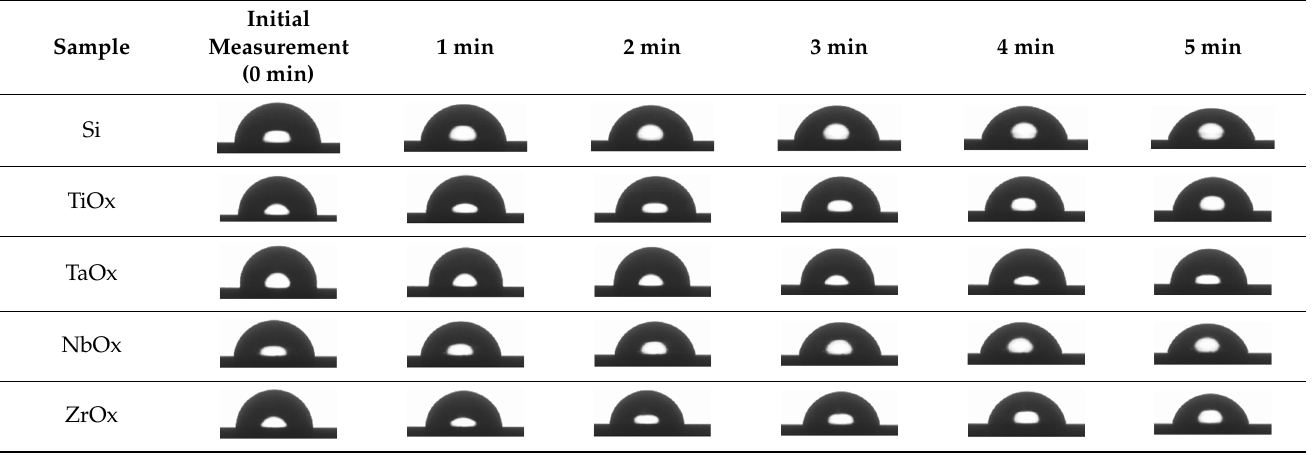
Table 3. Droplet size stability over time for water contact angle measurements.